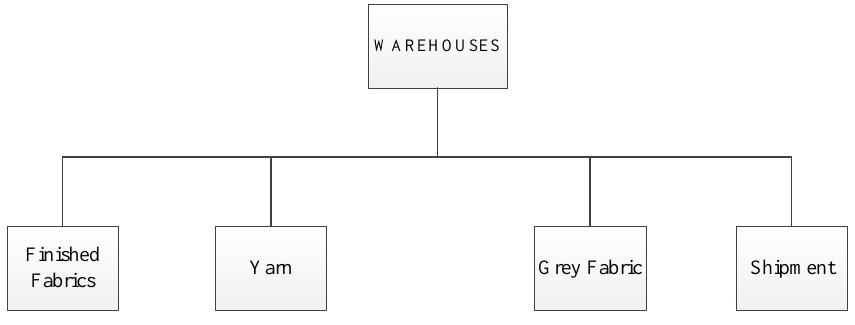
Figure 5. Division of the warehouse in the textile factory used for the case study.